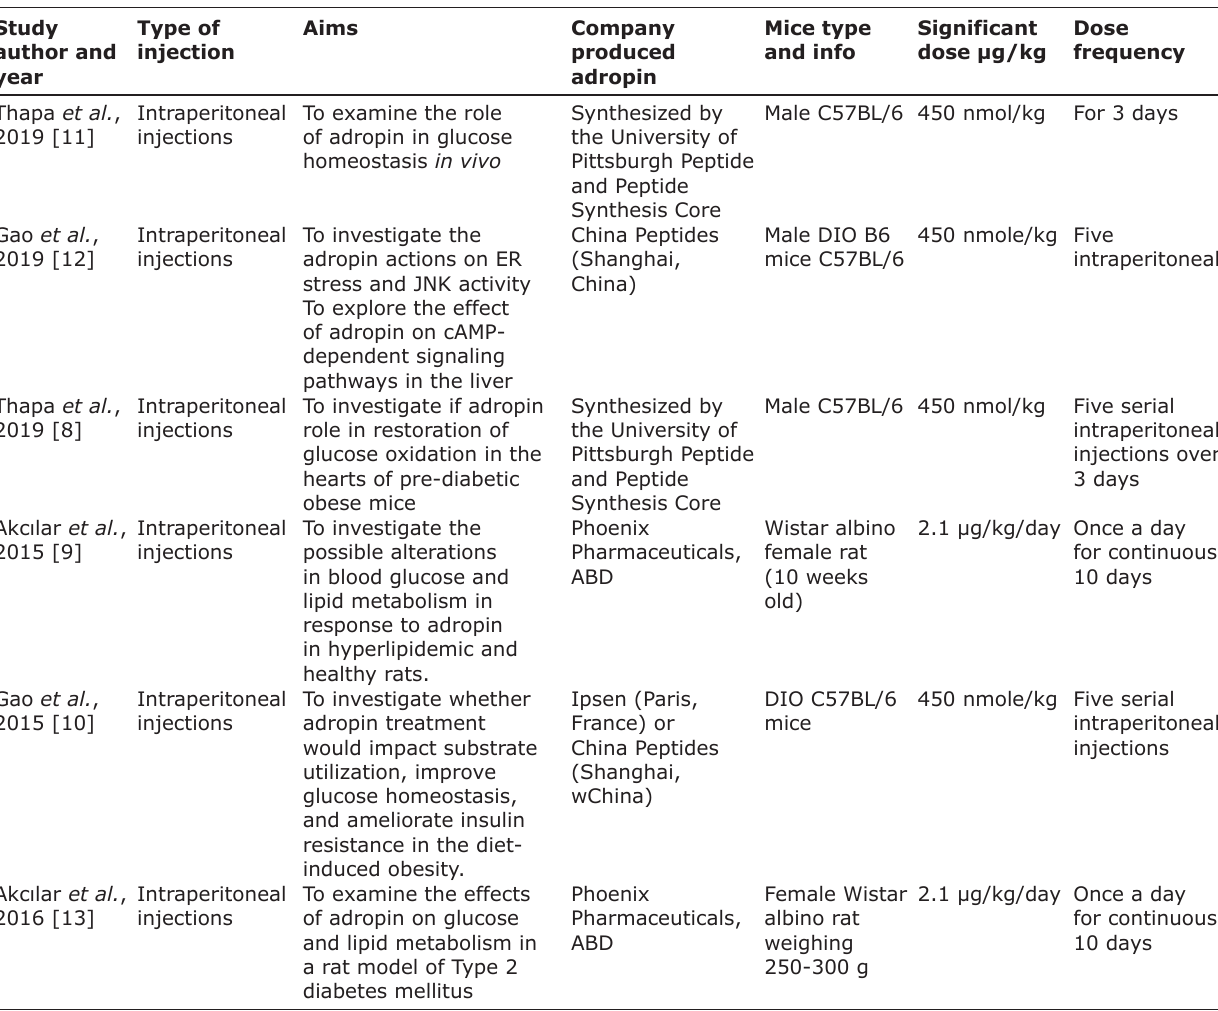
Table-2: Studies